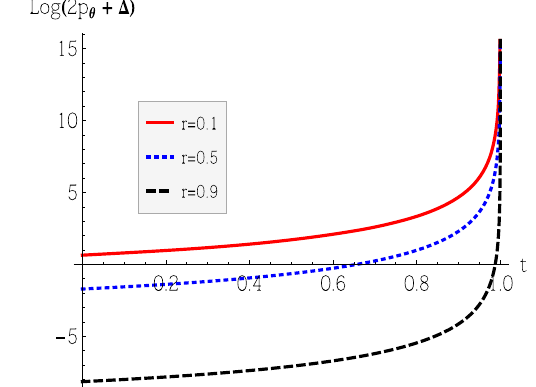
Fig. 6 Condition